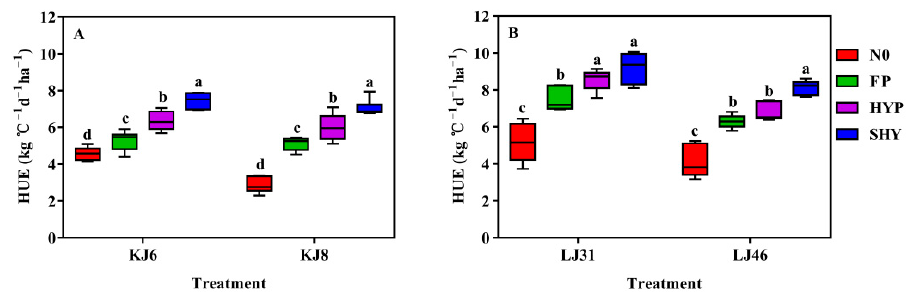
Figure 5. Heat-use efficiency (HUE) of different varieties at different sites (( A ) in Daqing; ( B ) in Suiling) and under different cultivation patterns (N0, FP, HYP, and SHY). KJ: Kenjing 6; KJ8: Kenjing 8; LJ31: Longjing 31; LJ46: Longjing 46; N0: no nitrogen application; FP: local farmer practice; HYP: high-yield, high-efficiency practice; SHY: super-high-yield practice. Bars are mean ± SE ( n = 3). Different letters indicate statistical significance at the p < 0.05 level under different treatments.